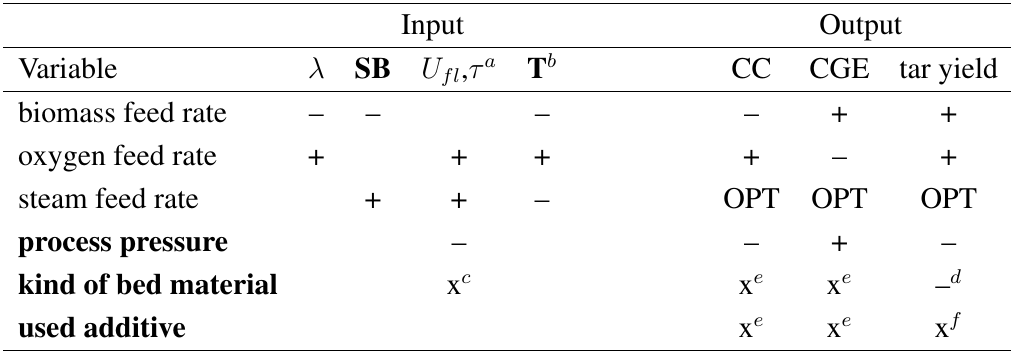
Table 9 . Main process variables and parameters, and their interactions assuming only one variable changing (increasing) at a time. Variables in bold face are discussed in more detail in the text. Symbols used: + (increase), – (decrease), OPT (optimal range exists to maximize or minimize the desired effect), x (other effect, see